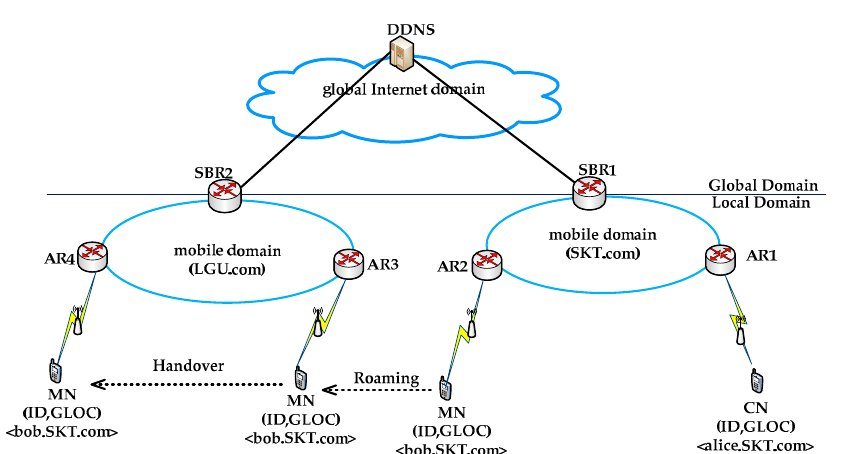
Figure 1. Mobility scenario for Identifier Locator Network Protocol (ILNP)-Global scheme.